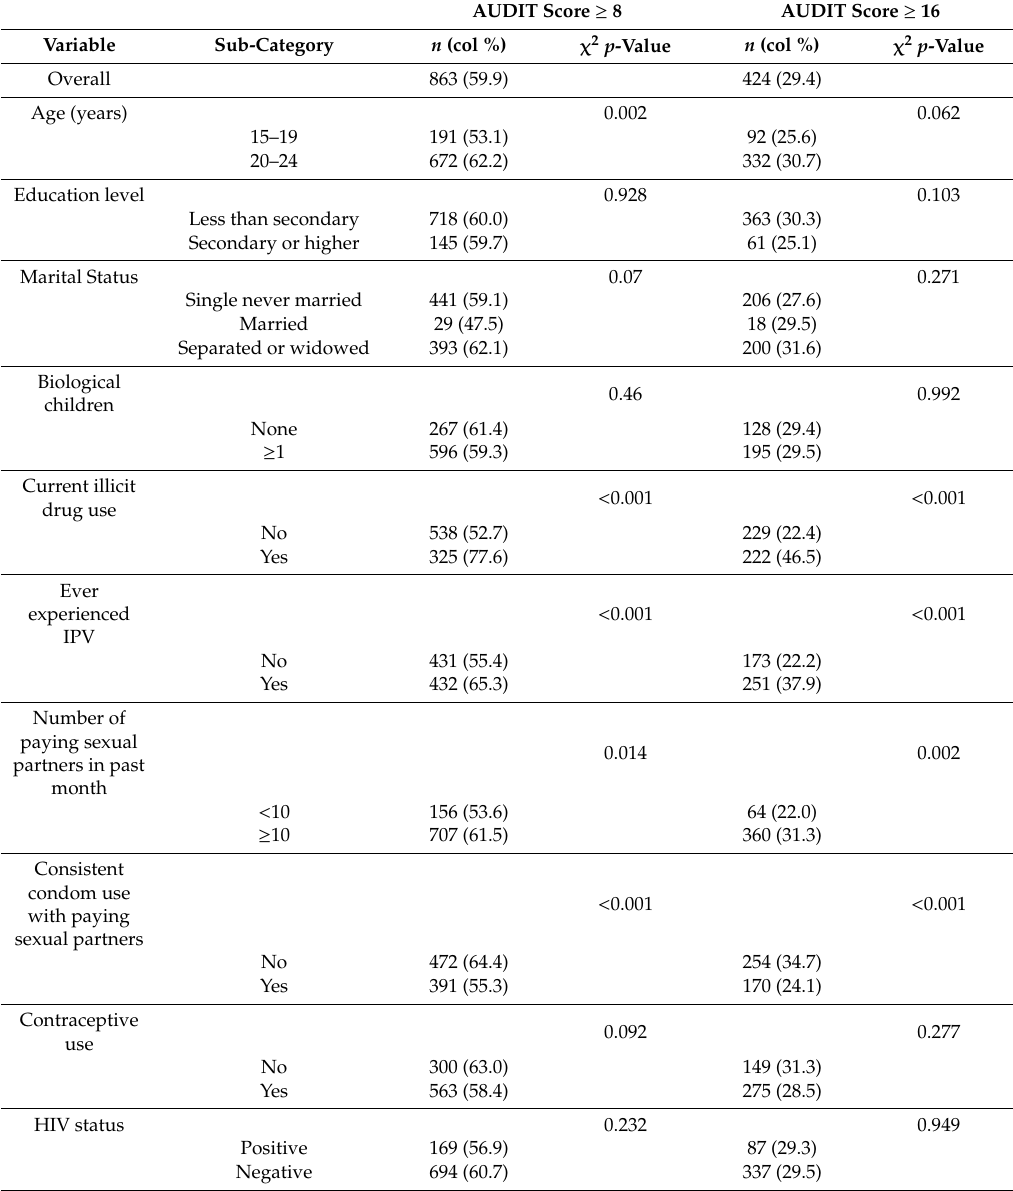
Prevalence of alcohol use disorders among AGYW by sociodemographic and behavioral